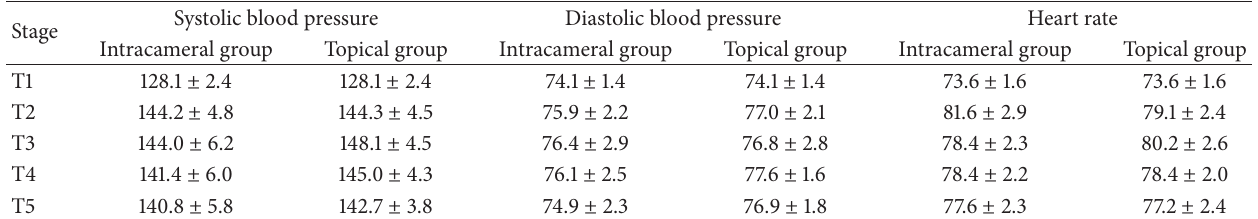
Table 2: Blood pressure (mmHg) and heart rate (bpm) at different stages of surgery in the two groups. Stage